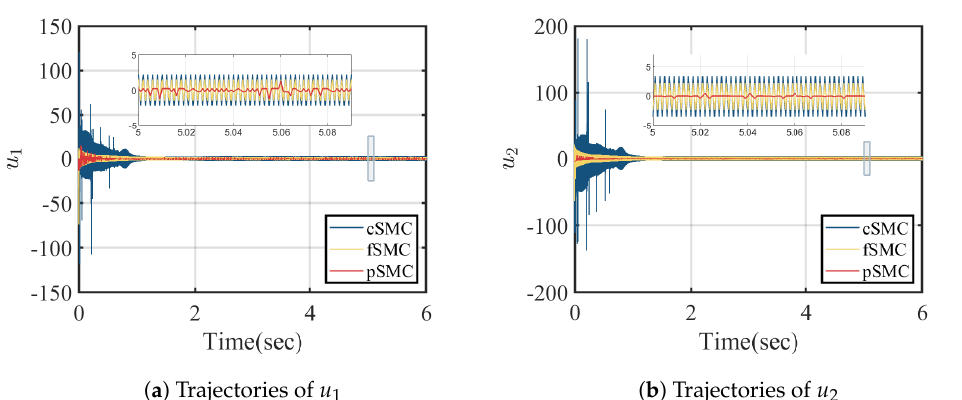
Figure 12. The trajectories of control variables u 1 and u 2 when ρ b = 0.6: cSMC (Blue solid line), fSMC (Yellow solid line) and pSMC (Red solid line).